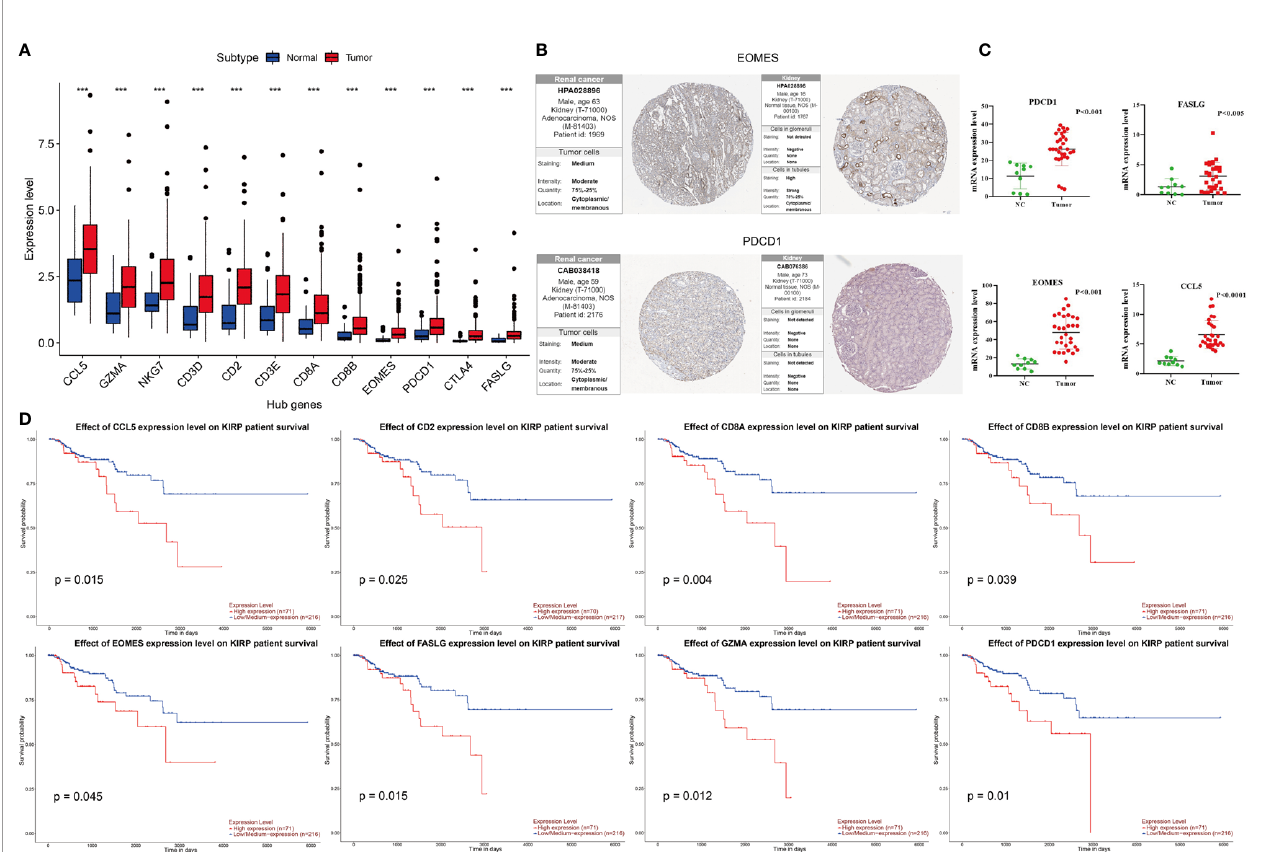
FIGURE 3 | Differential expression of hub genes in KIRP and survival curves of hub genes. (A) In the TCGA cohort, the expression of 12 hub genes in the tumor were higher than that in normal tissues, ***p < 0.001. (B) Immunohistochemical results of EOMES and PDCD1 in tumor and normal tissues. (C) mRNA expression levels of CCL5, FASLG, EOMES, and PDCD1 detected by RT-qPCR in tumor and normal tissues. (D) The high expressions (red line) of CCL5, CD2, CD8A, CD8B, EOMES, FASLG, GZMA, and PDCD1 were associated with poor